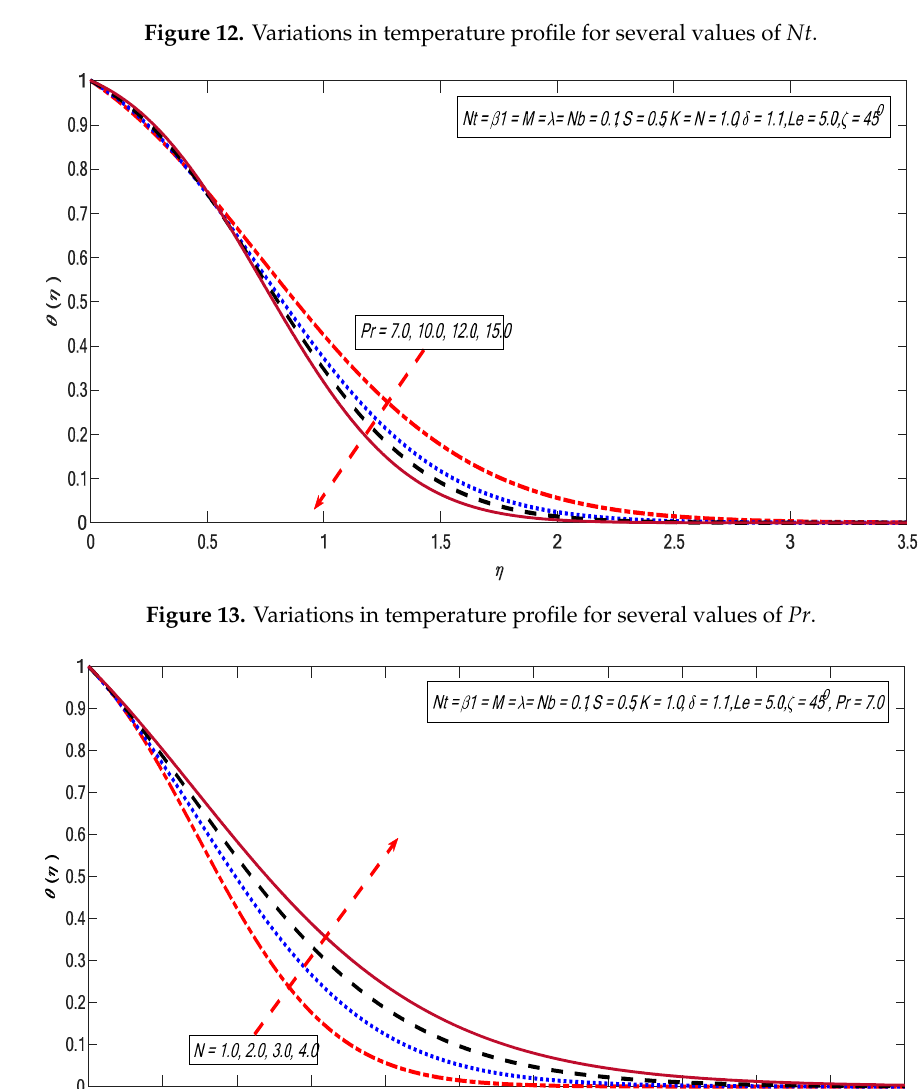
Figure 15. Variations in concentration profile for several values of 𝑀 .